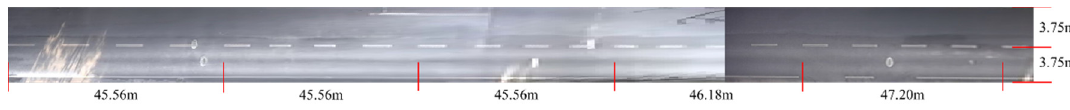
Figure 13. Actual road scene. ( a ) Camera 1; ( b ) Camera 2. Table 6. Camera calibration results of actual road scene.